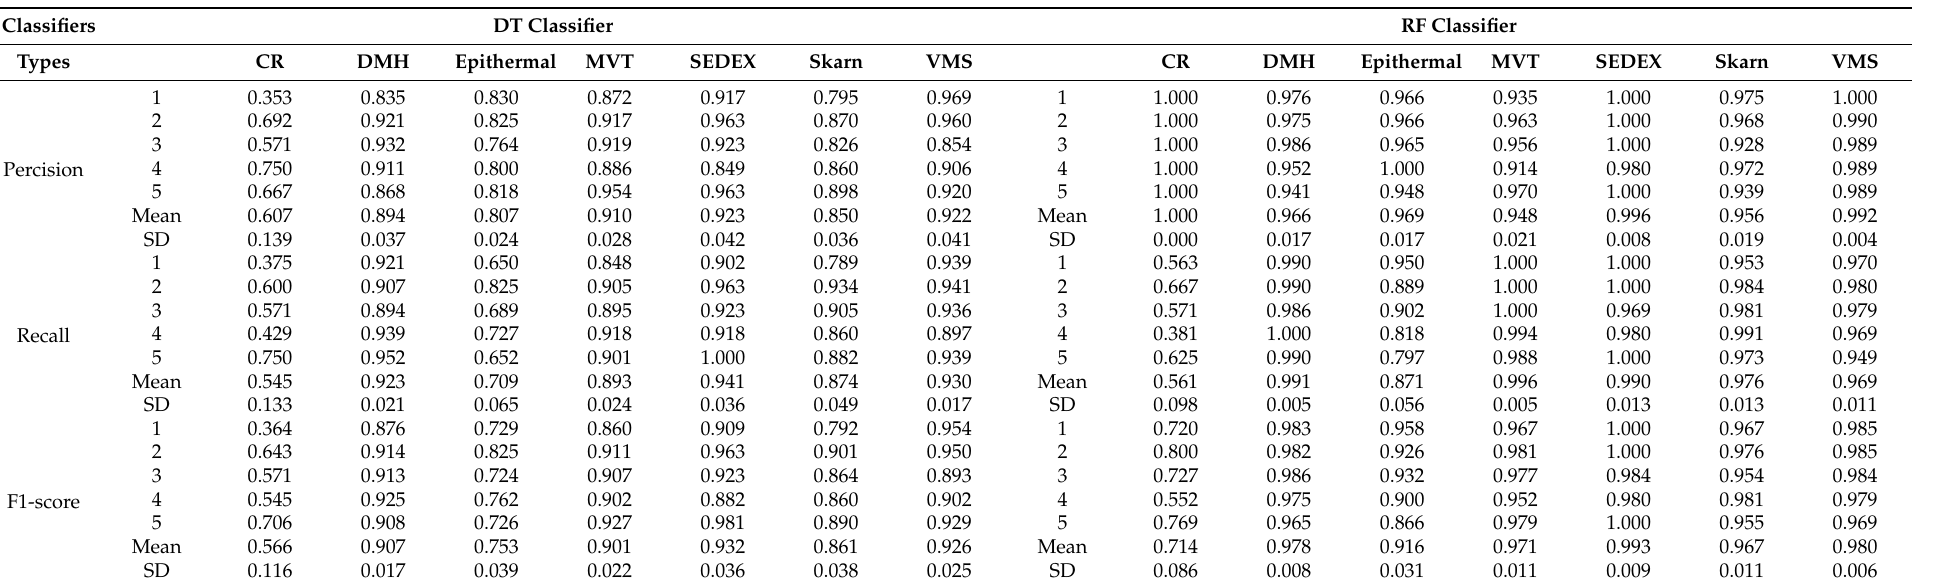
Table 2. Precision, recall, and F1 score of